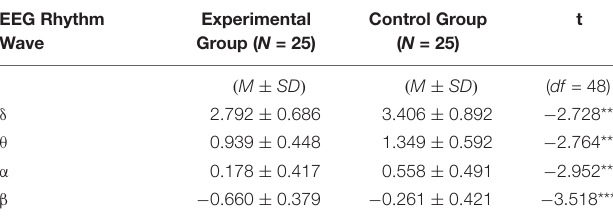
TABLE 2 | PSD value ( δ , θ , α , and β ) and t -test between experimental group and control group.